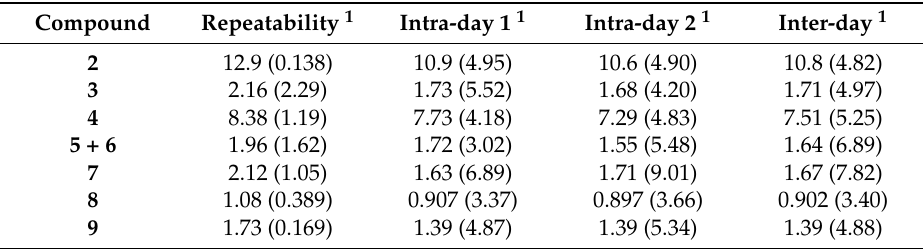
Table 2. Repeatability and precision of the UHPLC method.